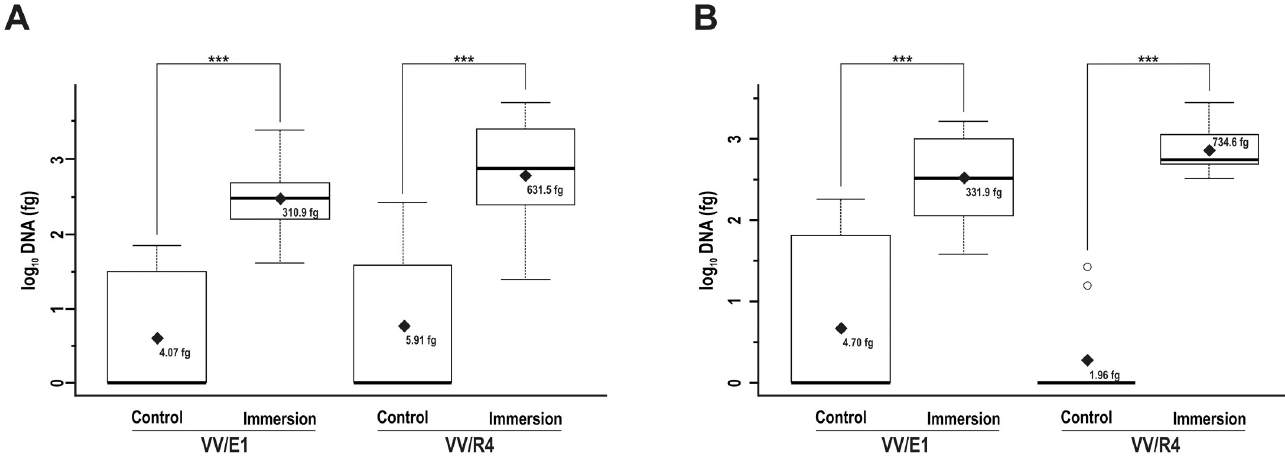
Fig 5. Quantification in RI and RS DNA samples from the Streptomyces sp. strains inoculated by immersion. Box plot showing the DNA levels from Streptomyces sp. VV/E1 and Streptomyces sp. VV/R4 strains in plants subjected to inoculation by immersion as compared to control plants in the (A) RI, and (B) RS areas. Black rhombuses show the average values (back transformed) for each treatment. Asterisks indicate existence of significant differences according the LSD-test performed: � p < 0.05; �� p < 0.01; ��� p < 0.001. Circles correspond to data outliers (falling outside the Q1-Q3 range).